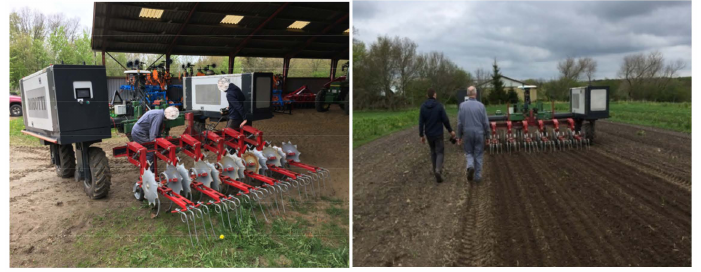
Figure 5. Mechanical weeder (Rod weeder), 3 (m), 5 (km/h), 2 (cm) depth. The test field was in Denmark and the robot drove the planned route automatically. Only four tracks were considered for this test. The length of the tracks is T1 = 131 (m), T2 = 141 (m), T3 = 170 (m), and T4 = 189 (m). Figure 6 demonstrates the test